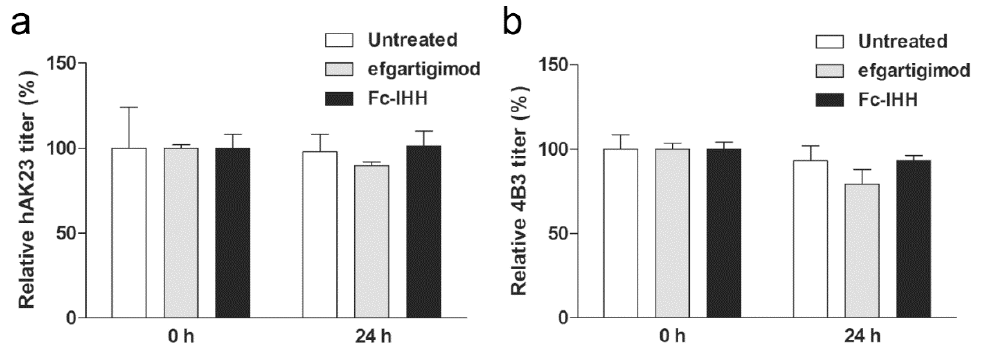
Figure 6. Antibody concentration in the culture medium is not significantly reduced over the assay time, and efgartigimod does not induce significant antibody degradation. Before and after treatment of hTert cells with the pathogenic and control antibodies (see the legend of Figure 4 for details), samples of the media were collected, and the amount of anti-Dsg3 antibodies in the medium was measured with an anti-Dsg3 ELISA. The untreated samples at 0 h were set as 100%, and all other samples were expressed as relative values (%). ( a ) hAK23, and ( b ) 4B3. The error bars show the SD of the mean values obtained from at least five independent experiments. Statistical analysis was done using two-way ANOVA with Bonferroni’s post-test. No significant differences were